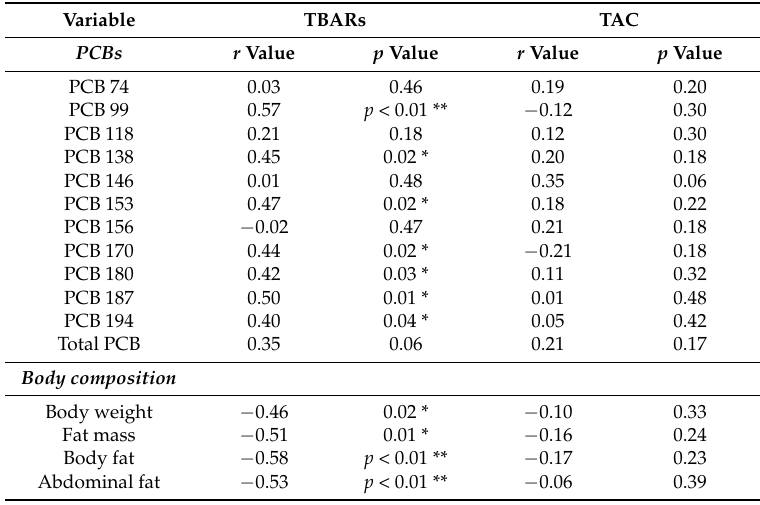
Table 7. Pearson correlation coefficients for the percent change in oxidative stress, PCBs, and body composition following the WM (Phase 2).